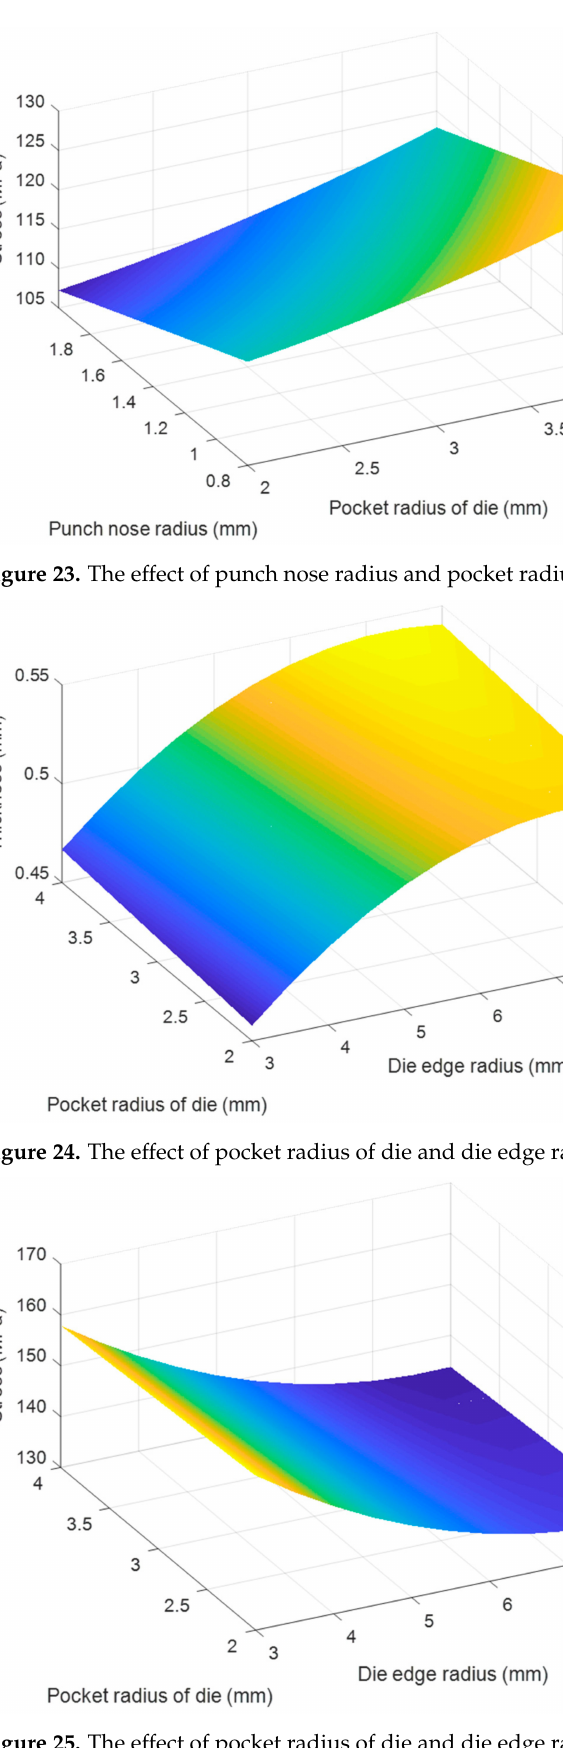
Figure 25. The effect of pocket radius of die and die edge radius on